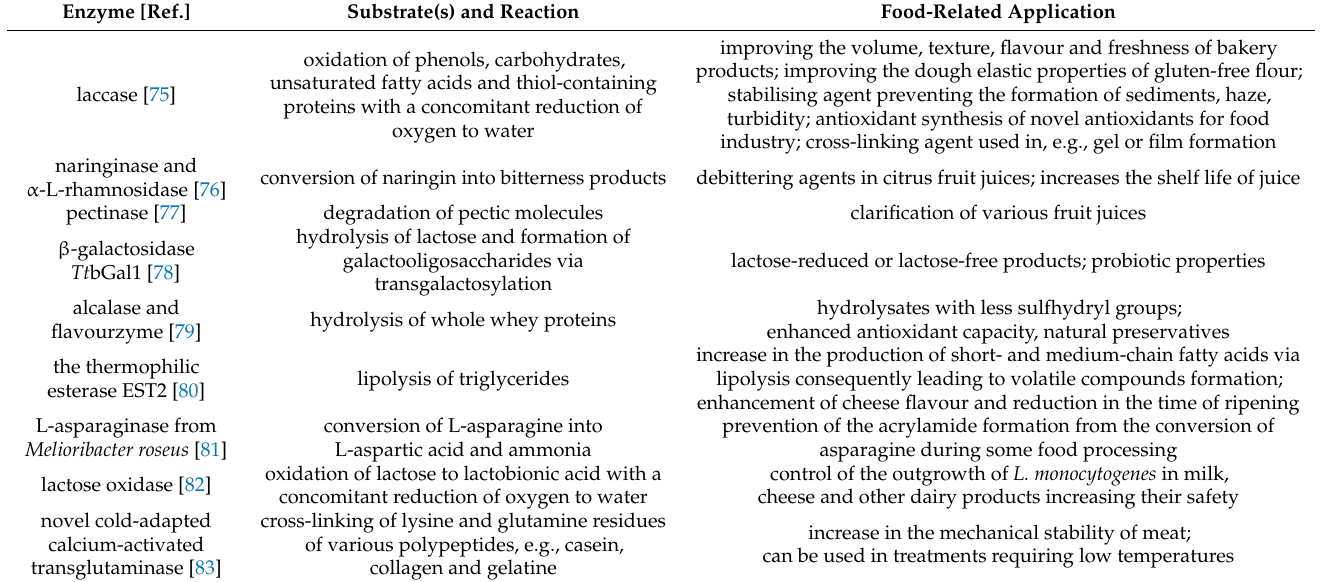
Table 3. Examples of enzymes and their most up-to-date food-related